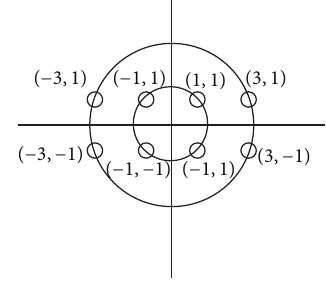
Figure 1: Rectangular 8-QAM constellation.